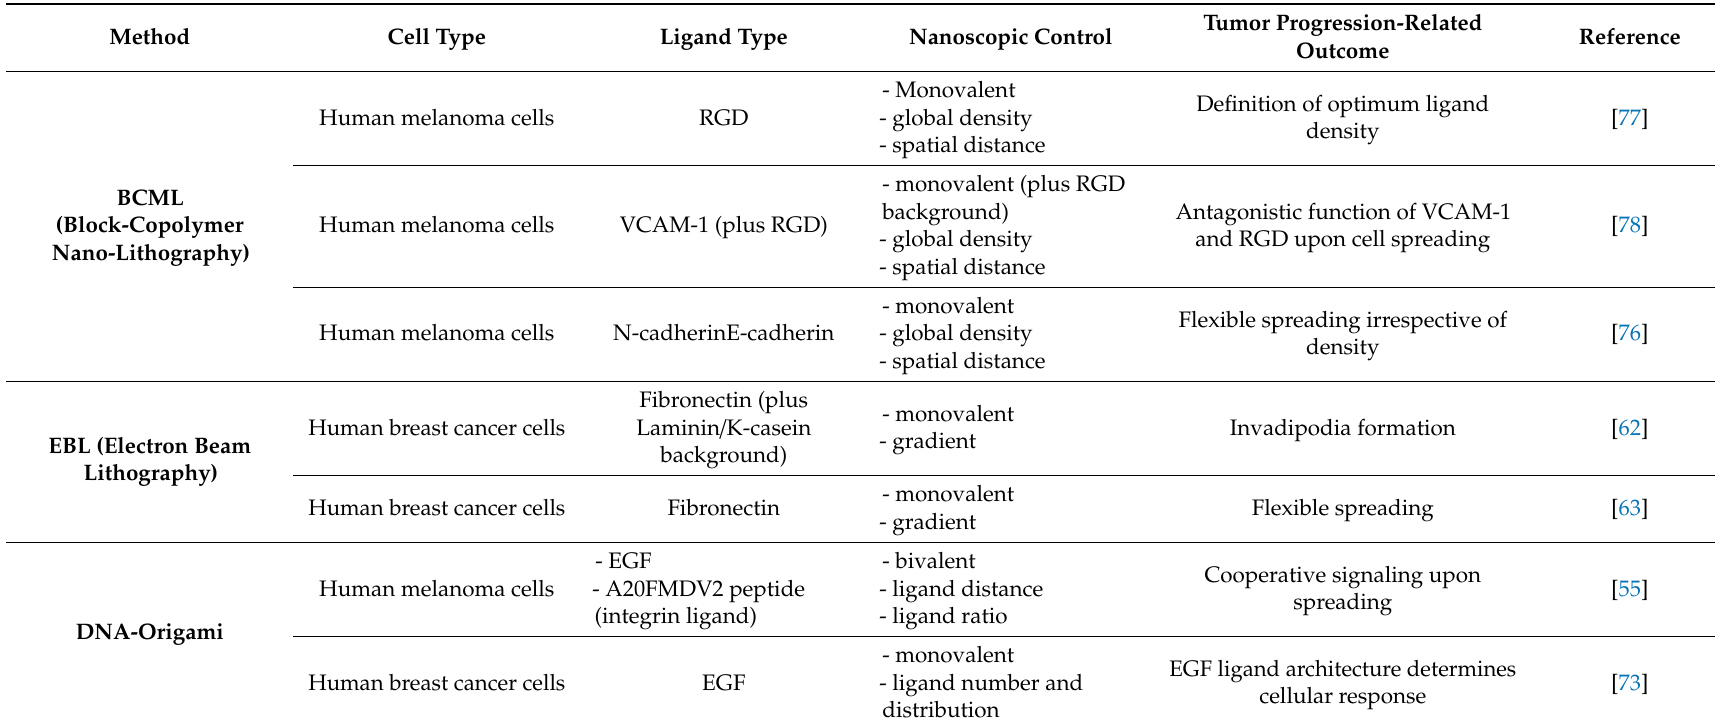
Table 1. Overview of selected nanomodel-systems alluded to in the text. The table highlights the methods used, the cell lines and ligands / receptors and the major findings regarding tumor progression-related